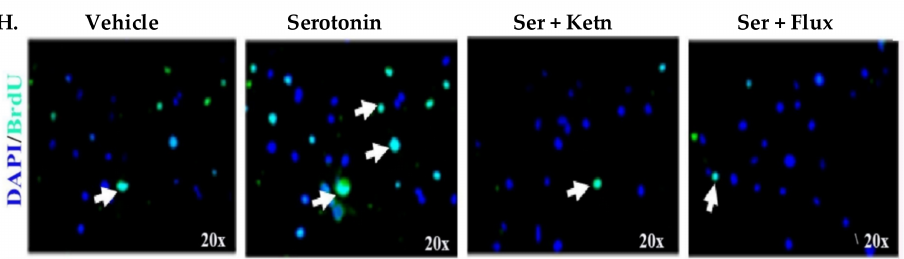
Figure 1. Comparative cellular effects of serotonin, ketanserin and fluoxetine drug treatments on ( A , E ) cell viability ( B , F ) apoptosis and ( C , G ) proliferation of human fibroblasts and neonatal keratinocytes cultures, respectively. ( D , H ) Immunofluorescent staining with anti-BrdU antibody (green) and 4, 6-diamidino-2 phenylindole (DAPI) nuclear stain (blue) in human fibroblasts and neonatal keratinocytes, respectively. White arrows marked BrdU + ve cells. Images scale; 20 × resolution. Results were presented as mean ± Standard Deviation (SD), (* p < 0.05, ** p < 0.01), n =